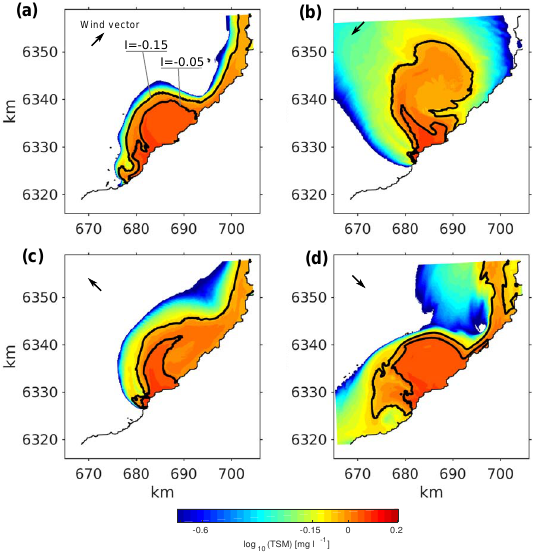
Figure 6. Instantaneous surface TSM concentration maps for sim- ulation with uniform ambient density and a constant wind speed of 4ms − 1 blowing in a downstream (a) , upstream (b) , offshore (c) and onshore (d) direction at 6 T from the start of the simulation. Solid lines represent TSM concentrations of log 10 (TSM) = − 0 . 15 and = − 0 . 05. The coordinate system is on the UTM-34v